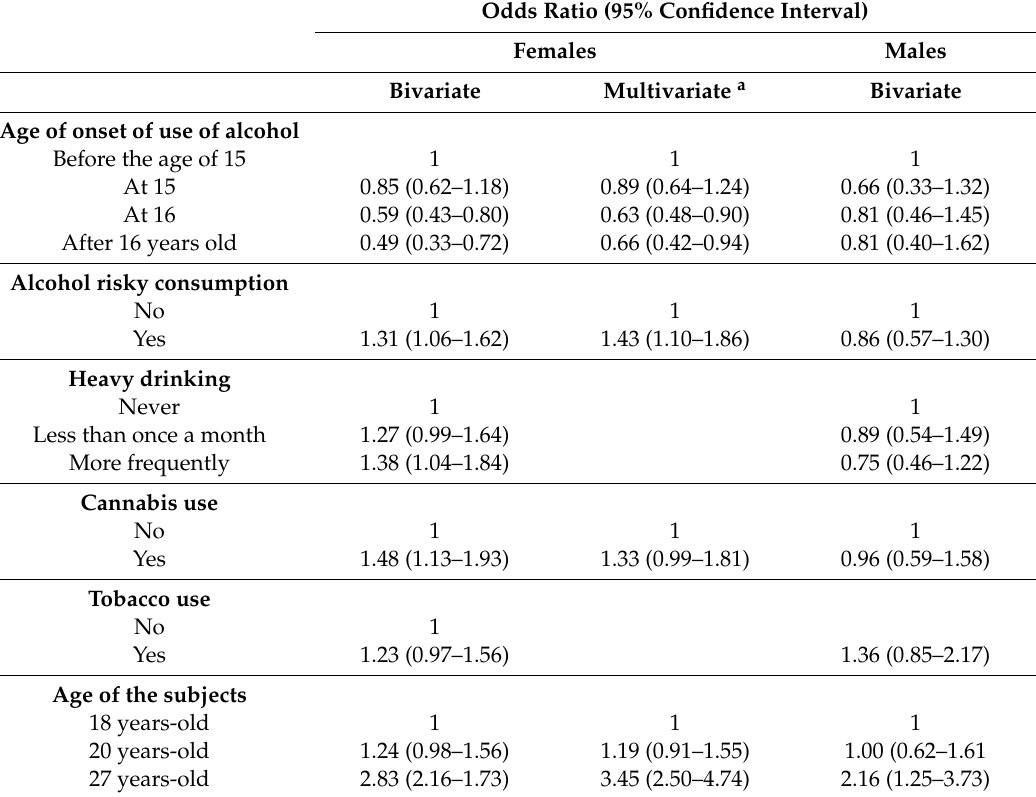
Table 4. Influence of age of onset of alcohol use and substance use in the non-medical use of prescription drugs. Logistic